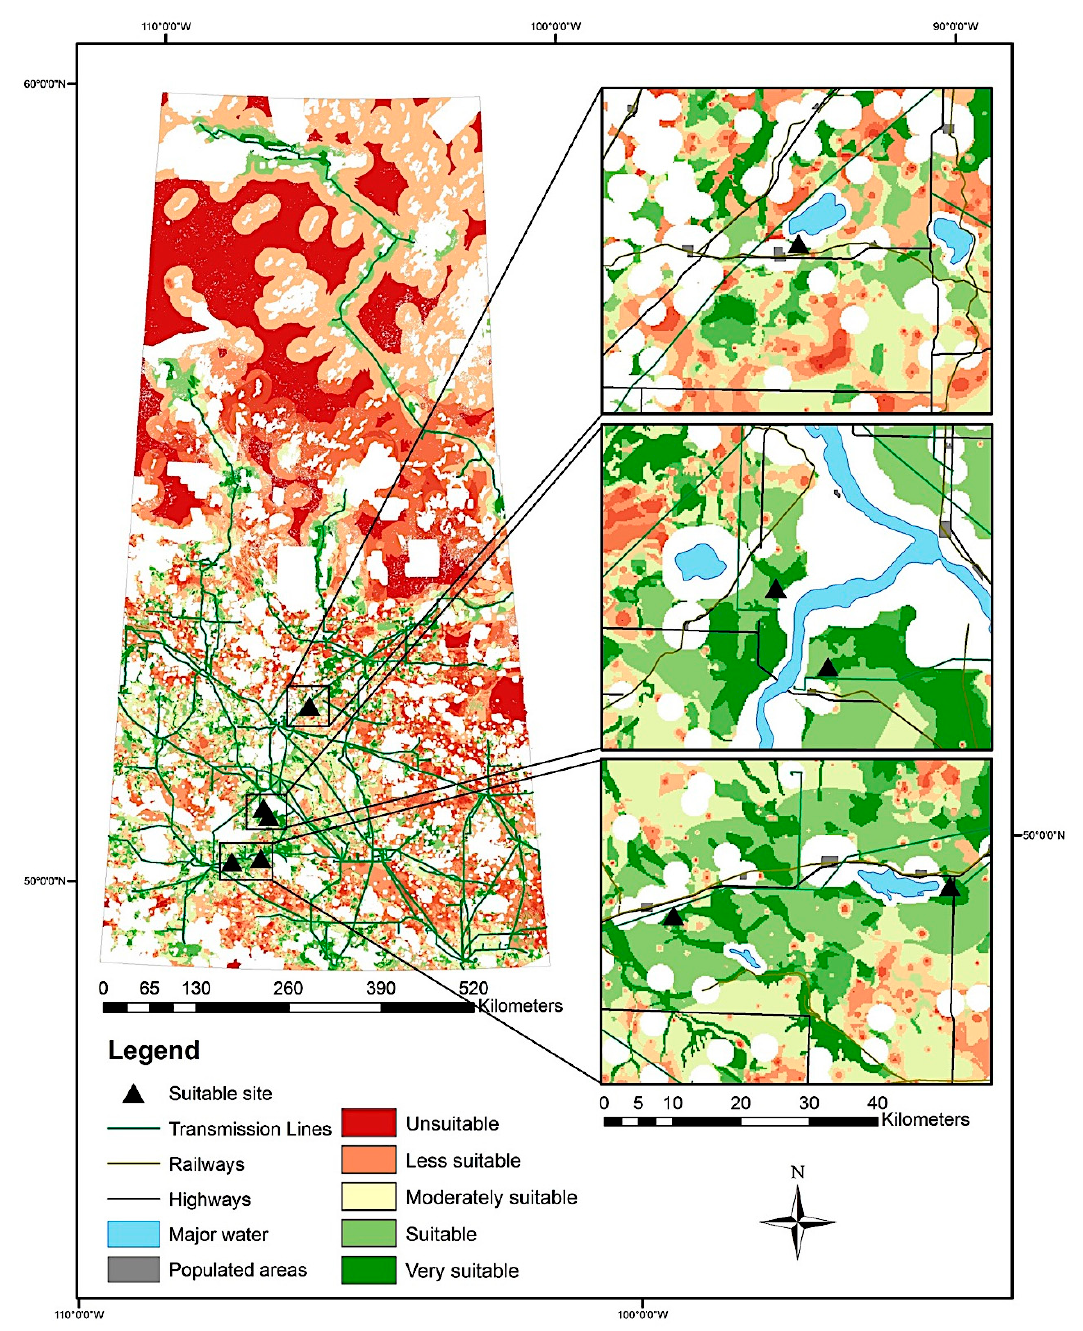
Figure 9. Example of suitable SMR sites.